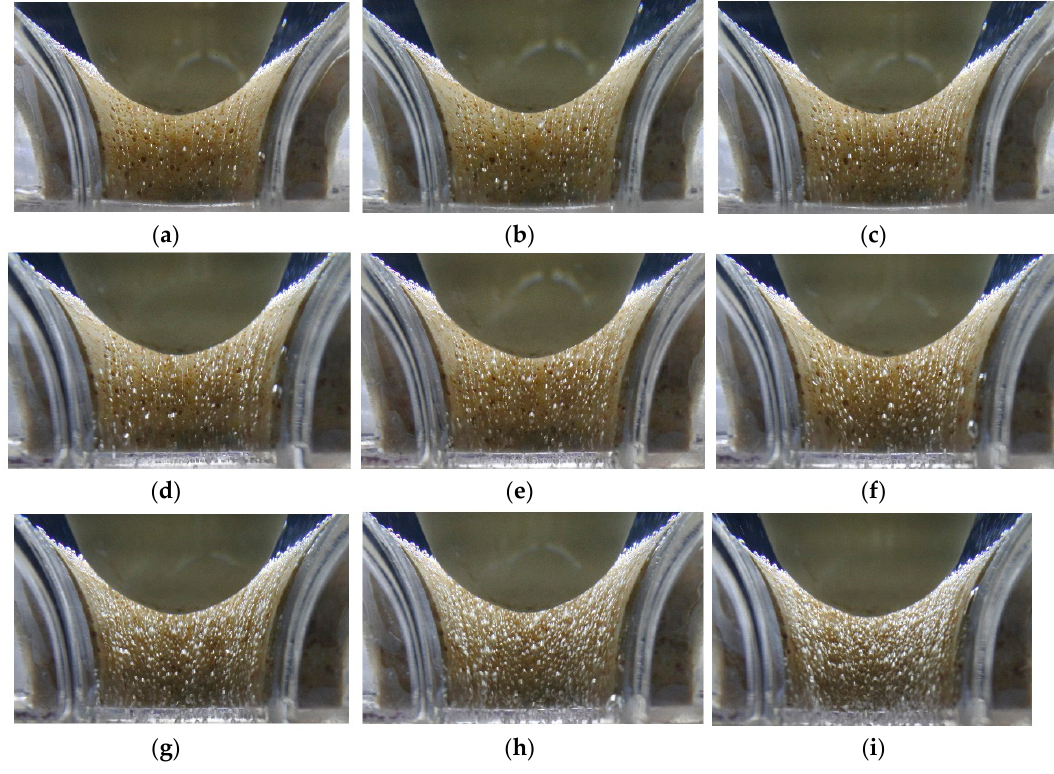
Figure 5. Distribution of argon bubbles on the inner surface of nozzle for different argon flow rates: ( a ) 8 L/h; ( b ) 16 L/h; ( c ) 24 L/h; ( d ) 32 L/h; ( e ) 40 L/h; ( f ) 50 L/h; ( g ) 100 L/h; ( h ) 150 L/h; ( i ) 200 L/h. The average diameter of argon bubbles on the inner surface of the nozzle with different argon flow rates is shown in Figure 6. When the argon flow rate increases from 8 L/h to 200 L/h, the average diameter of argon bubbles increases from 0.17 mm to 1.44 mm. Since the number of effective